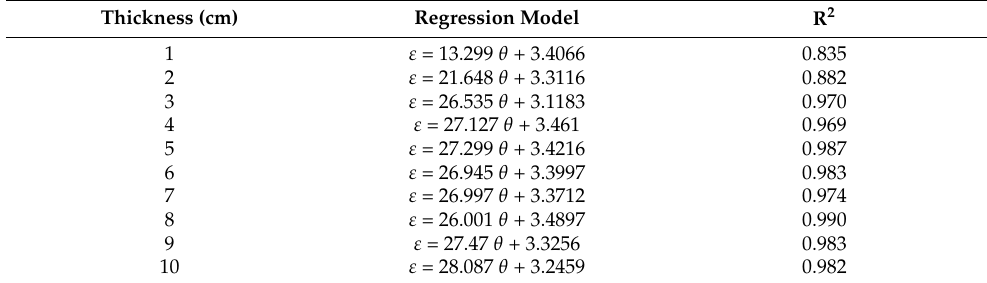
Table 3. Mathematical dependences between sample moisture (cm 3 /cm 3 ) and apparent permittivity values read by Sensor A for particle sample thickness.